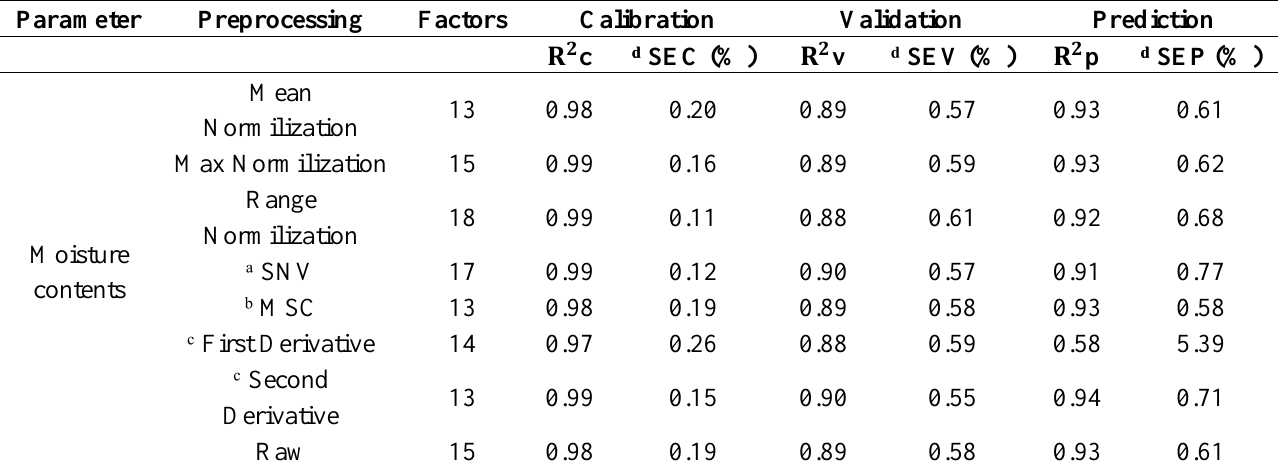
Table 2. PLS results with NIR region (700–1,000 nm).